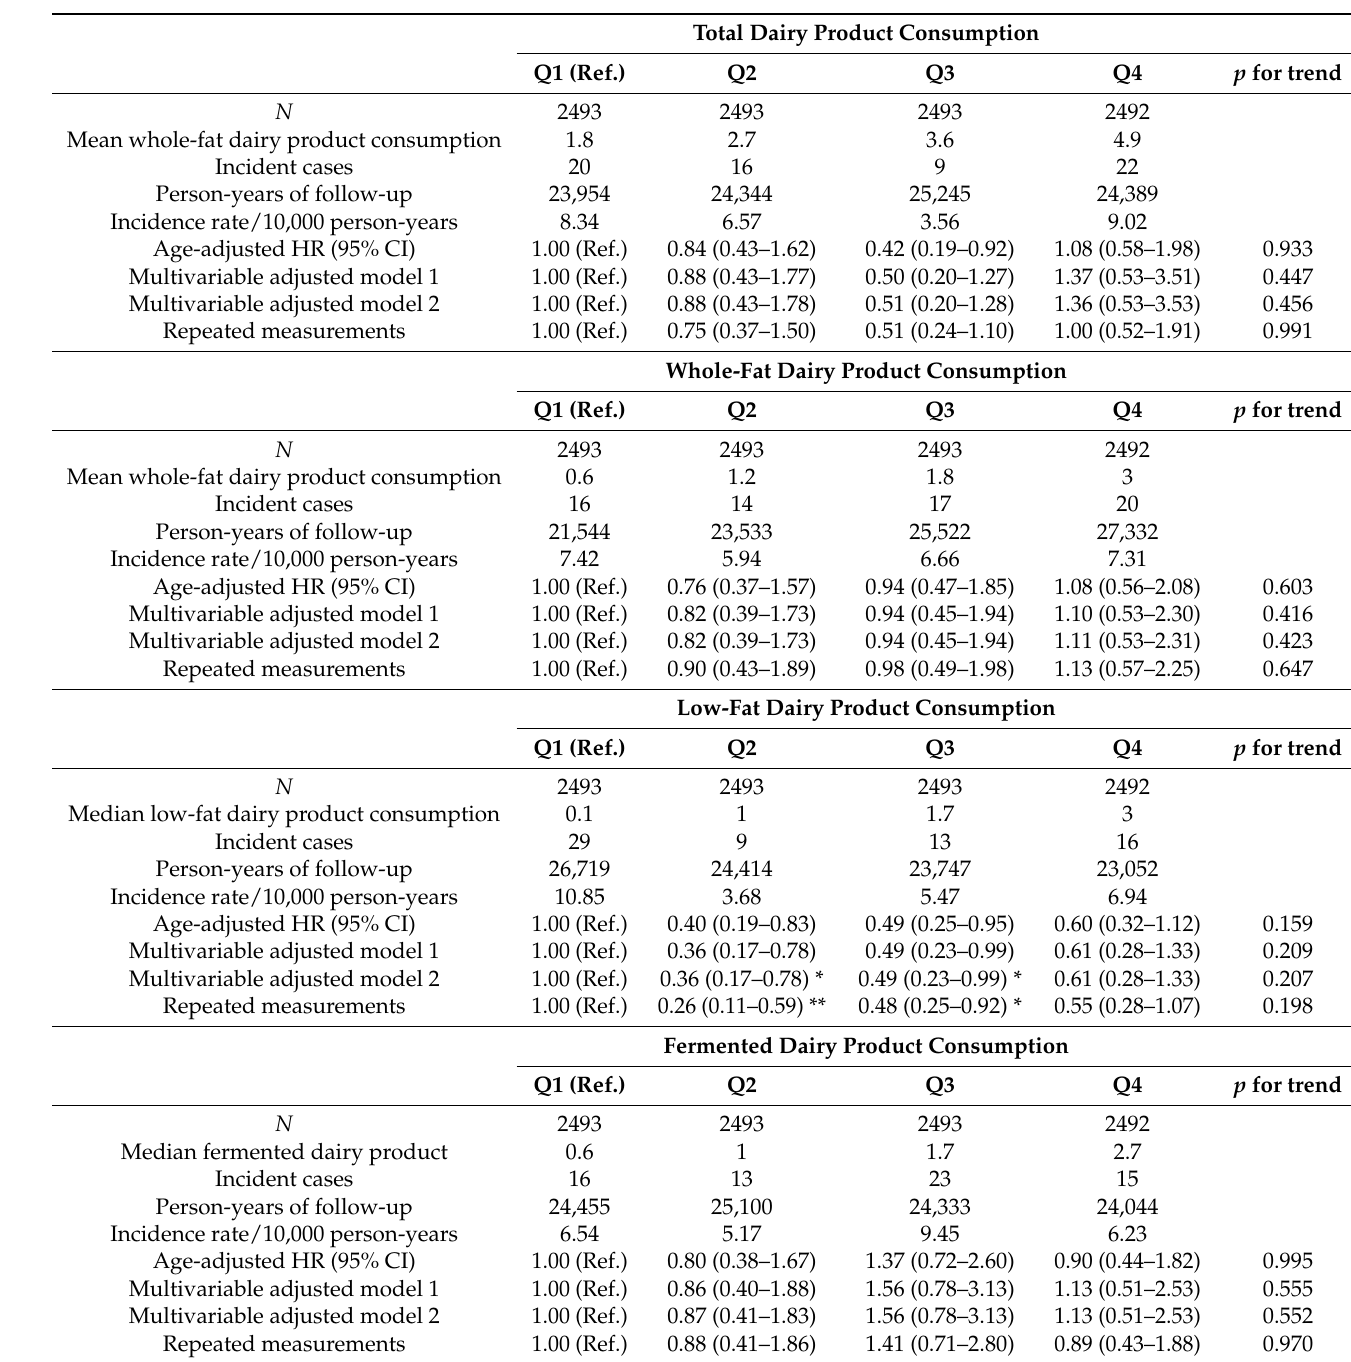
Table 3. Hazard ratio (HR) and 95% confidence intervals (CI) of confirmed premenopausal breast cancer cases according to the categories of baseline total dairy, whole-fat, low-fat, and fermented dairy product consumption among 9971 women of the SUN